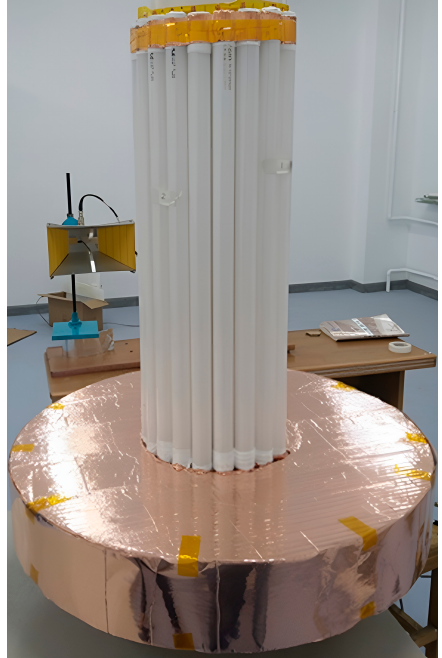
Figure 2. Picture of the plasma antenna system.